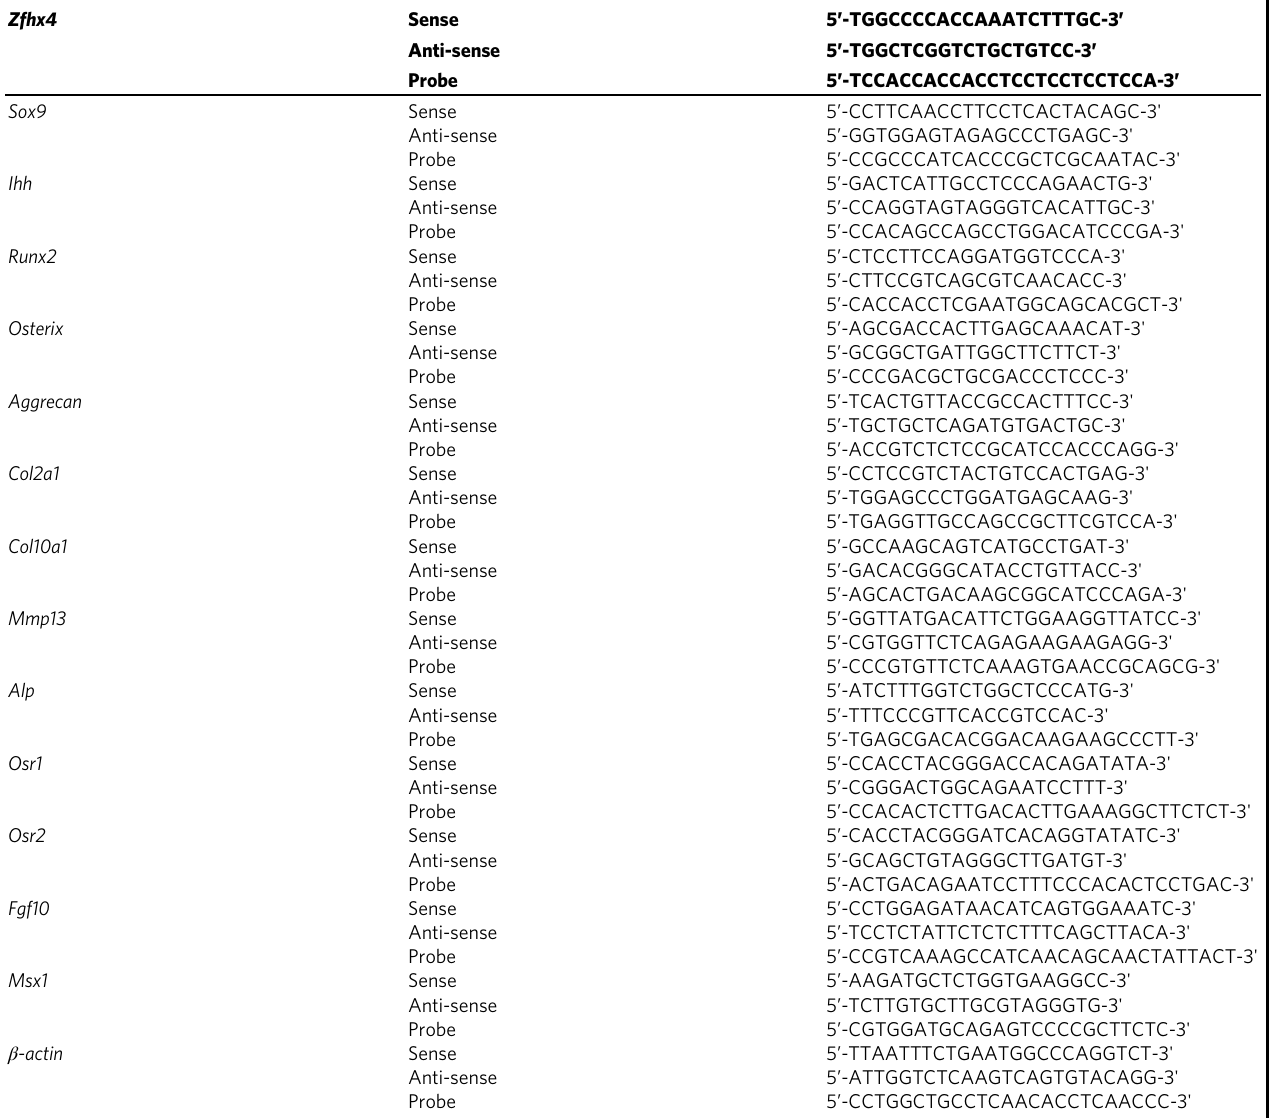
Table 1 List of sequences of Taqman probe sets for real-time RT-PCR